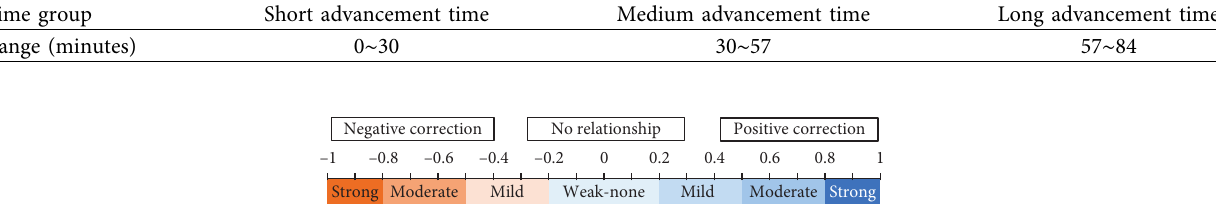
Table 7: Advancement time grouping table.